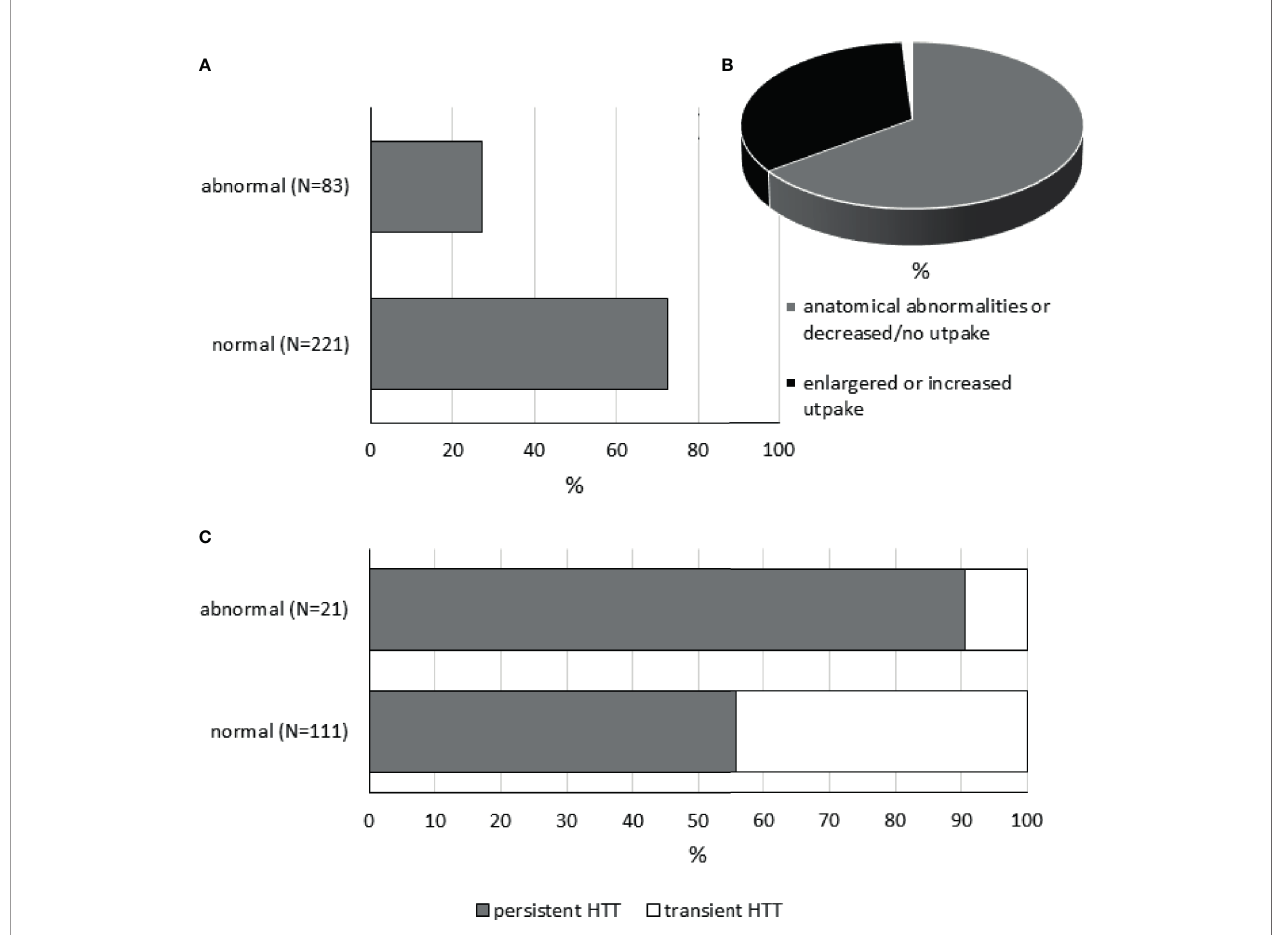
FIGURE 2 | Thyroid imaging tests in neonatal HTT. Panel (A) shows the percentages of cases with normal and abnormal fi ndings. Panel (B) is a pie chart showing the proportion of patients with anatomical abnormalities (hypoplasia, hemiagenesis, or ectopic thyroid gland) or decreased radionuclide uptake or no uptake (in gray, N = 54), enlarged thyroid gland, or increased radionuclide uptake (in black, N = 28), or data not available (in white, N = 1). Panel (C) shows the percentages of persistent and transient conditions in subjects with normal or abnormal fi